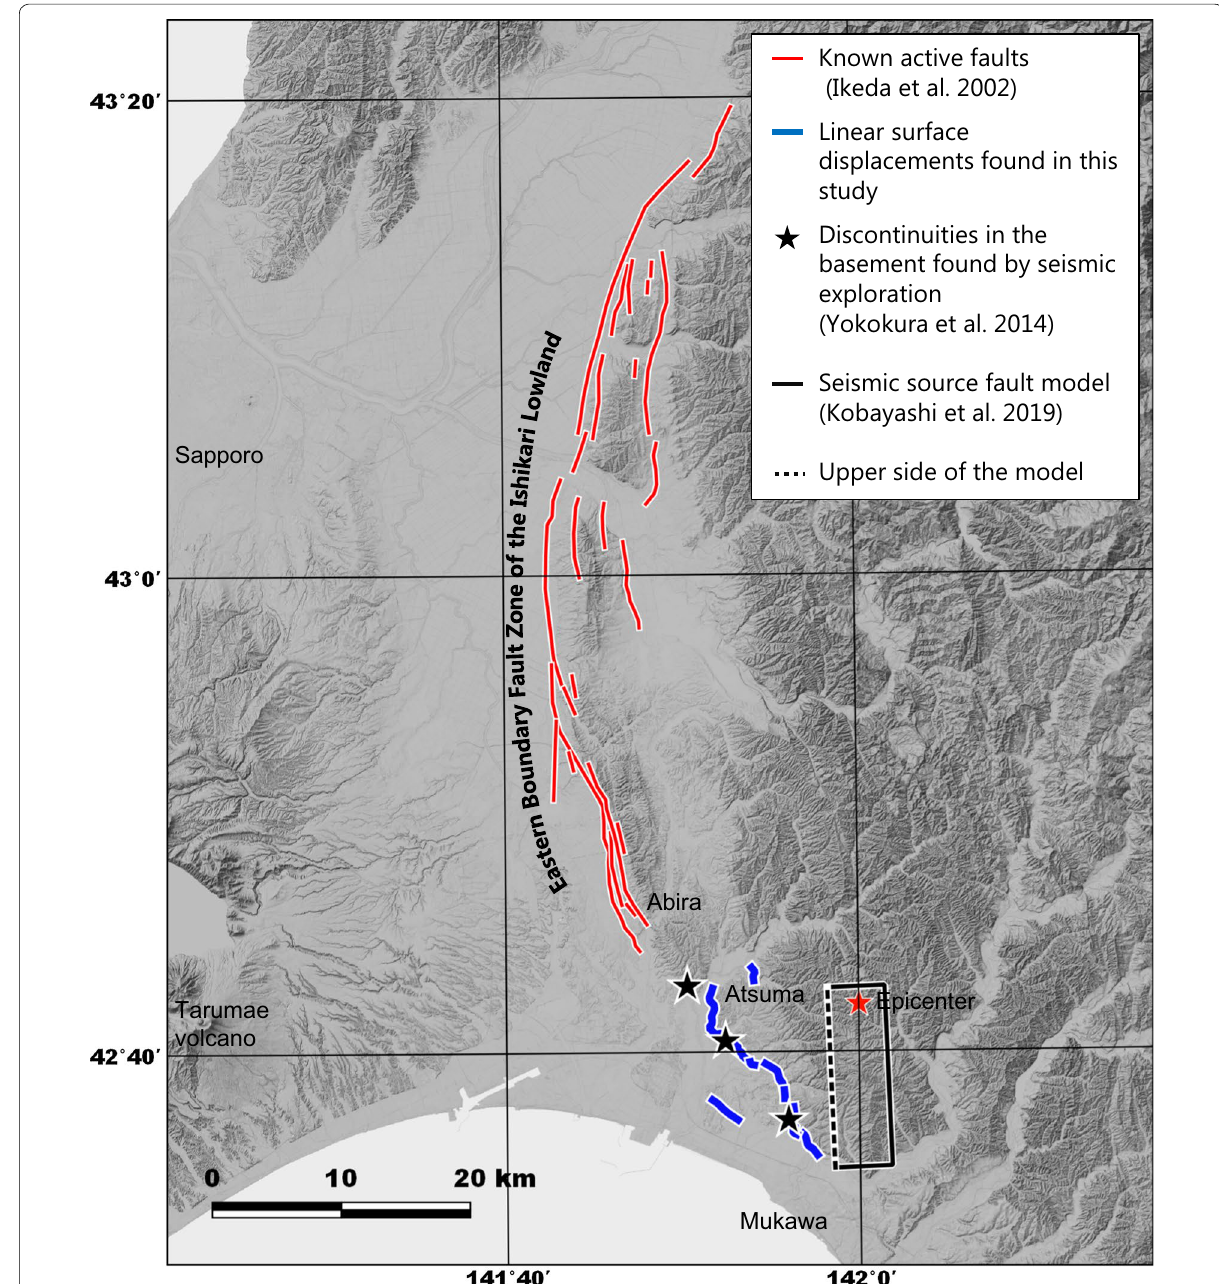
Fig. 8 Linear surface displacements (blue lines) detected by SAR interferograms and known active faults (red lines marking the Eastern Boundary Fault Zone of the Ishikari Lowland; Ikeda et al. 2002) on shaded topography. Black stars indicate the positions of discontinuities in the basement found by seismic exploration (Yokokura et al. 2014). The red star shows the epicenter of the 2018 Hokkaido Eastern Iburi Earthquake (Earthquake Research Committee 2018). The black rectangle indicates a source fault plane (projected on the map) modeled by Kobayashi et al. (2019) and the dotted line indicates the upper side of the